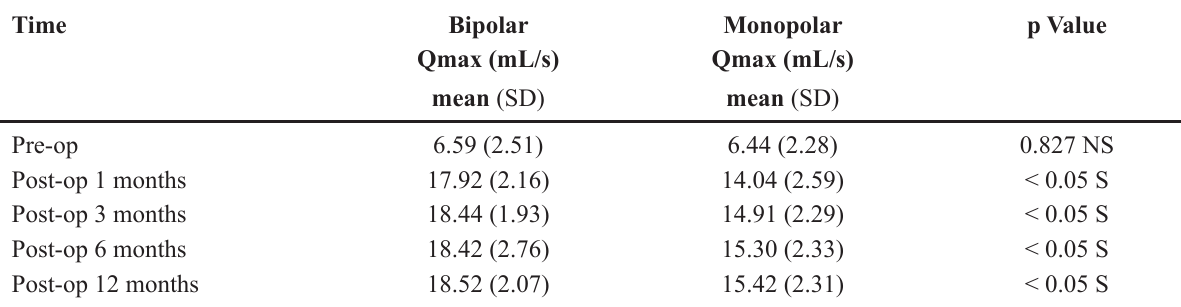
Qmax = maximum flow rate; SD = standard